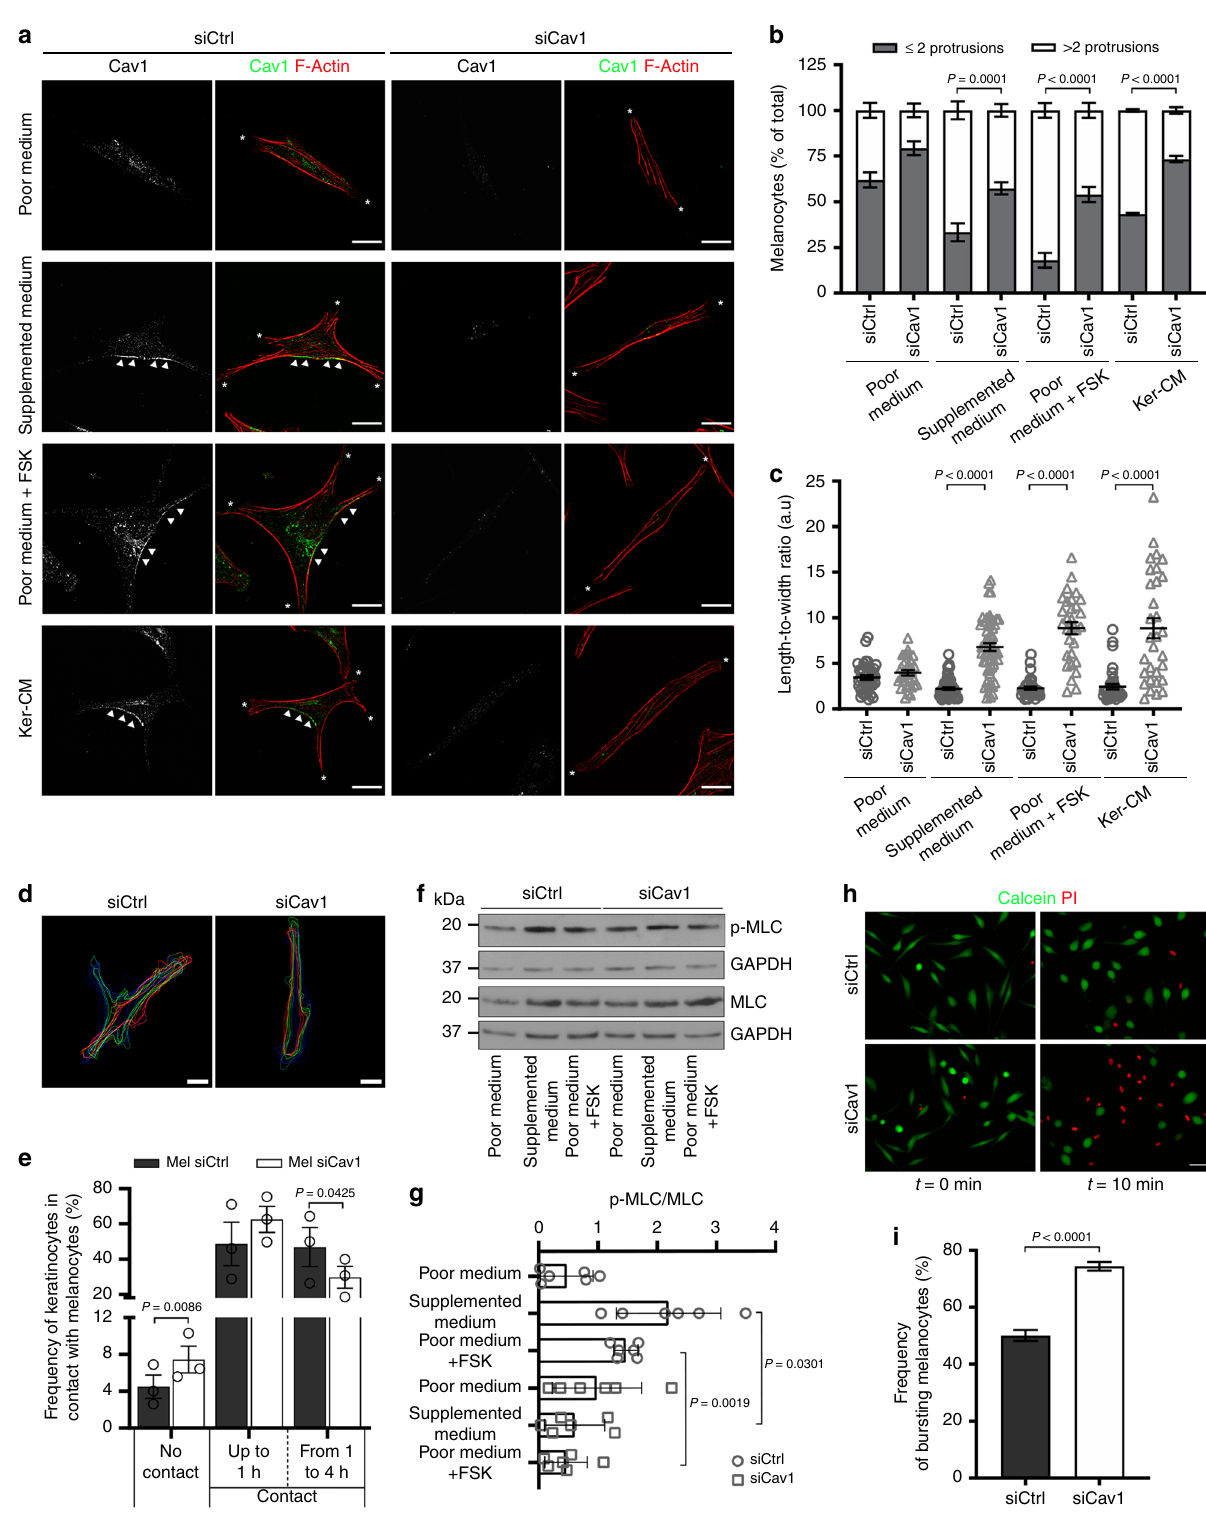
membrane permeant cytoplasmic green- fl uorescent dye calcein- AM and exposed to a 30 mOsm hypo-osmotic shock in the presence of propidium iodide (PI), a non-permeant red- fl uorescent DNA intercalating agent. A loss of plasma membrane integrity is revealed by a decrease or absence of the calcein-AM signal while acquiring a positive signal for propidium iodide. After 10 min of hypo-osmotic shock, Cav1-depleted melanocytes